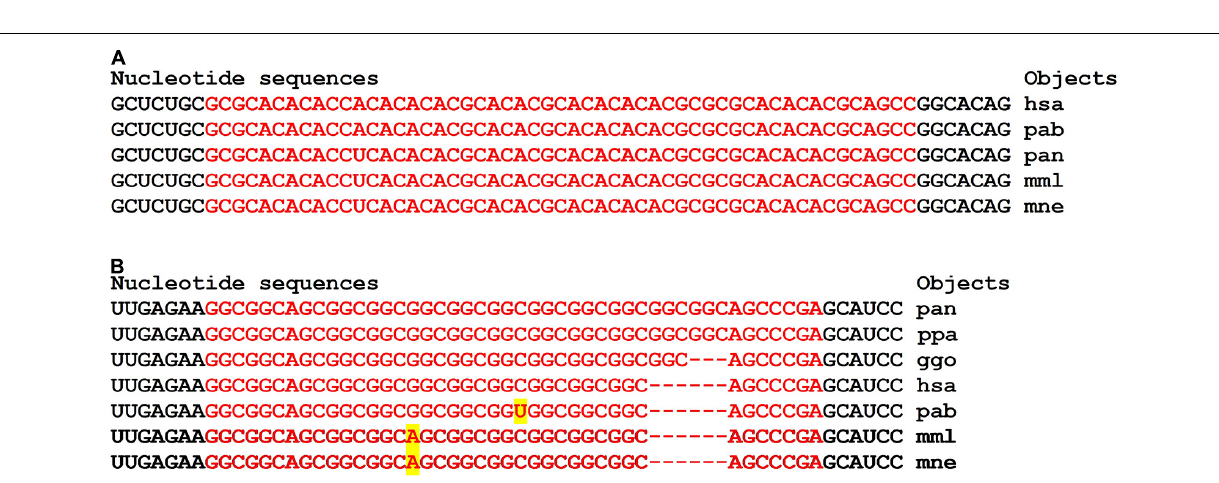
Frontiers in Genetics |